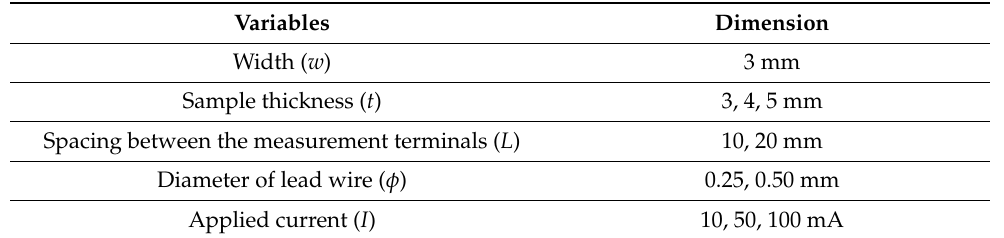
Figure 2. Schematic diagram of specimen. Table 1. Experiment variables of DC 4-point method.